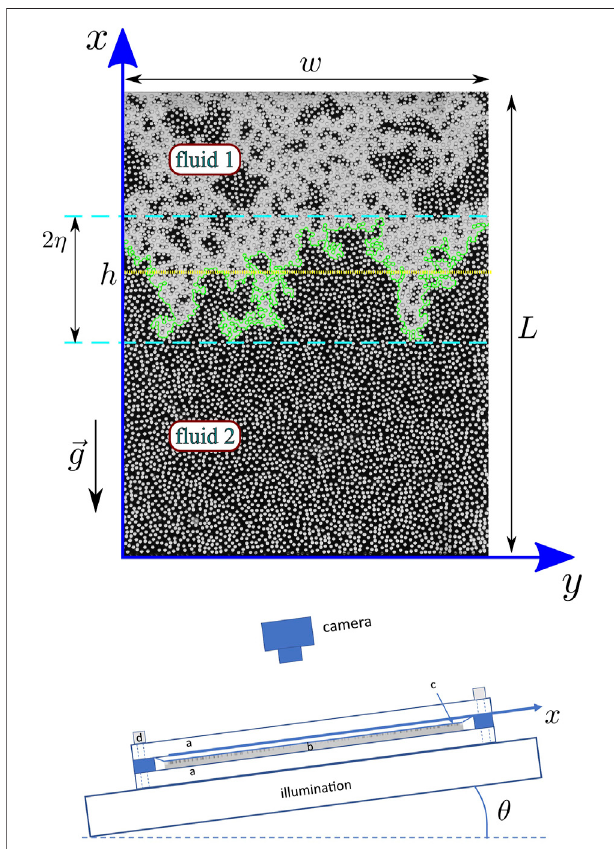
FIGURE 1 | Upper fi gure: A nonwetting fl uid 1 invades another wetting fl uid 2 in a porous model of width w , length L and coordinate system (x,y). A syringe pump is connected to the lower side and the model is open to air on the upper side. The model can be tilted with an effective gravitational constant g (cid:1) g 0 sin( θ )alongthexdirectionofthemodel,where g 0 (cid:1) 9.82 m/ s 2 . The average position of the front is h and the width of the front is 2 η . Lower fi gure: Cross section of the experimental model system (A) shows two transparent Plexiglassplates, (B) the 3D printed porous model, (C) aPVC fi lm keptunder pressure toclose the model and (D) screws that clamp the model. The model is illuminated from below and pictures are taken from